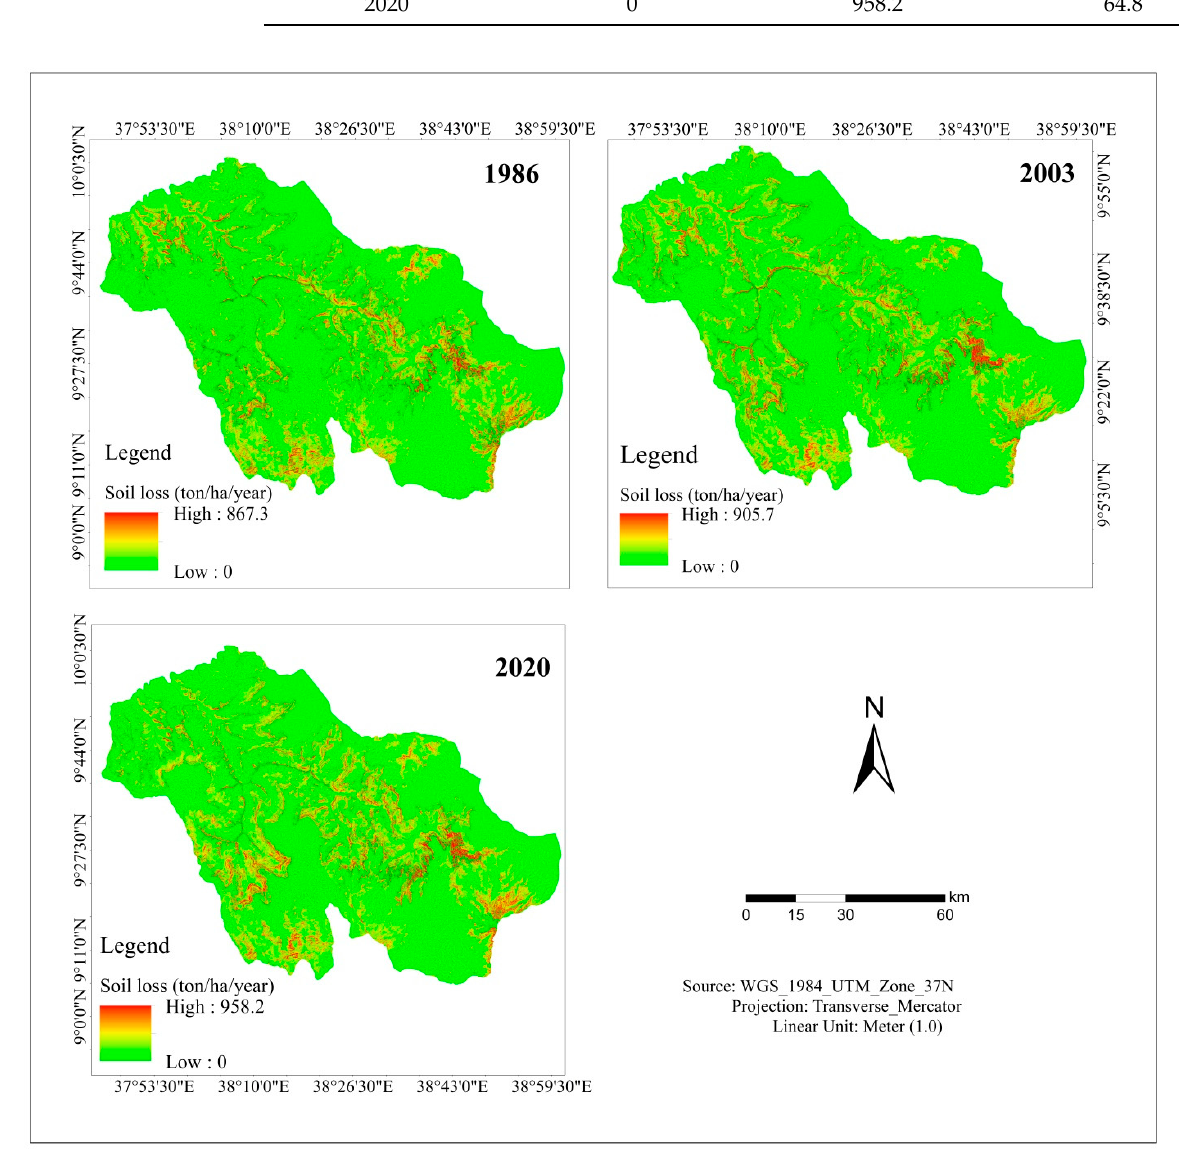
Figure 9. Soil erosion severity of Muger Sub-basin in 1986, 2003, and 2020.